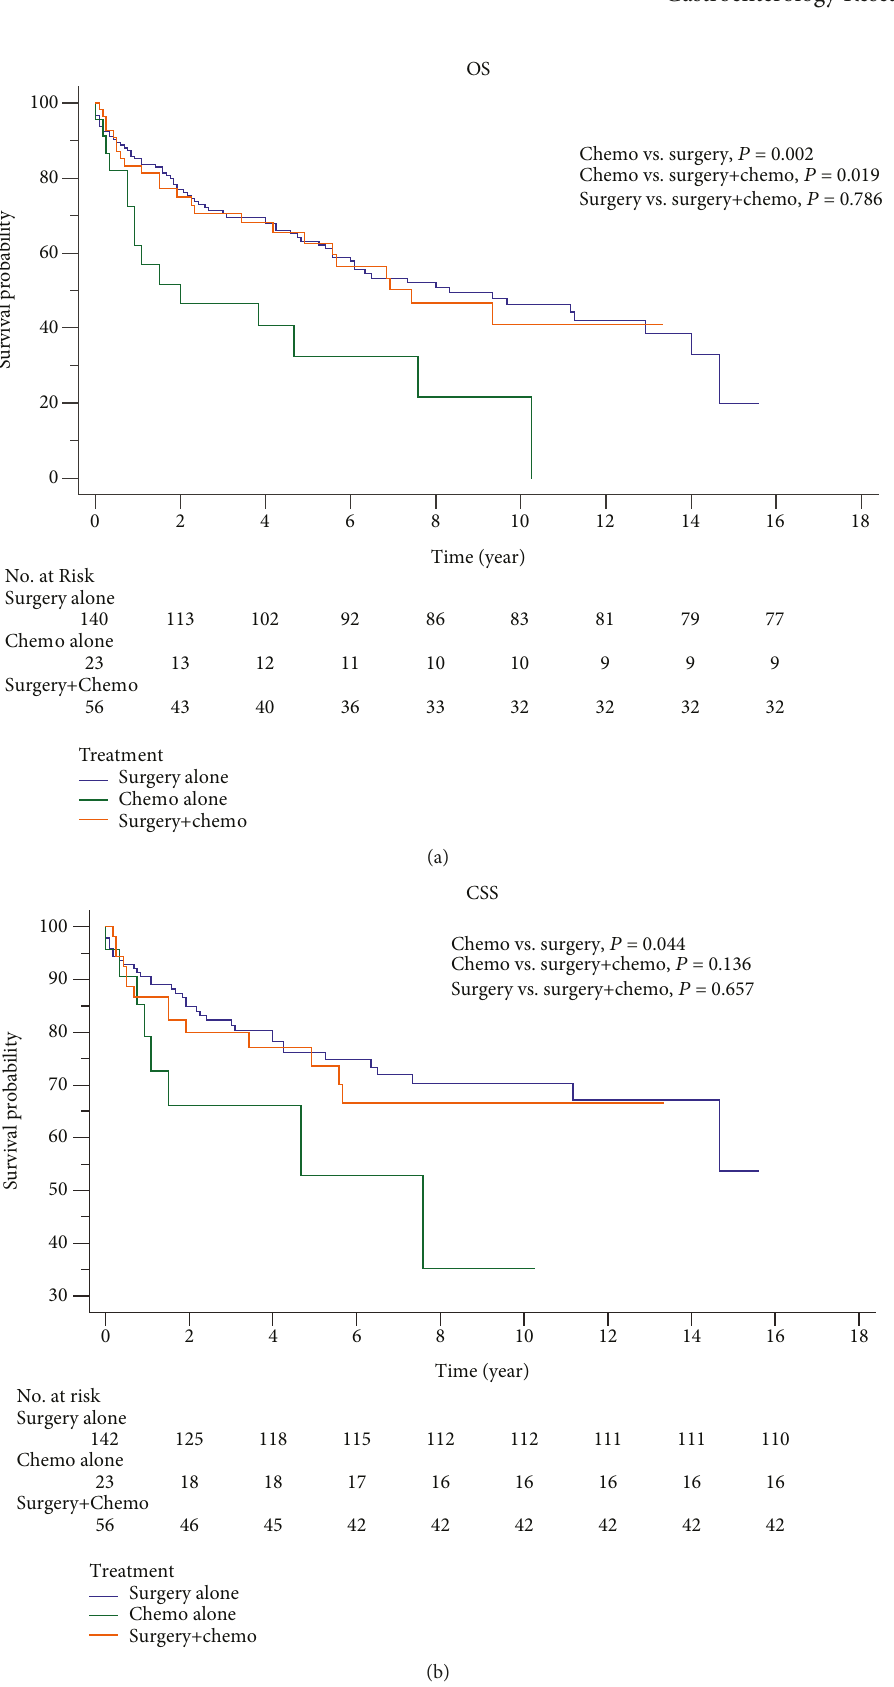
Figure 5: Kaplan-Meier analysis between di ff erent therapy modalities in colonic